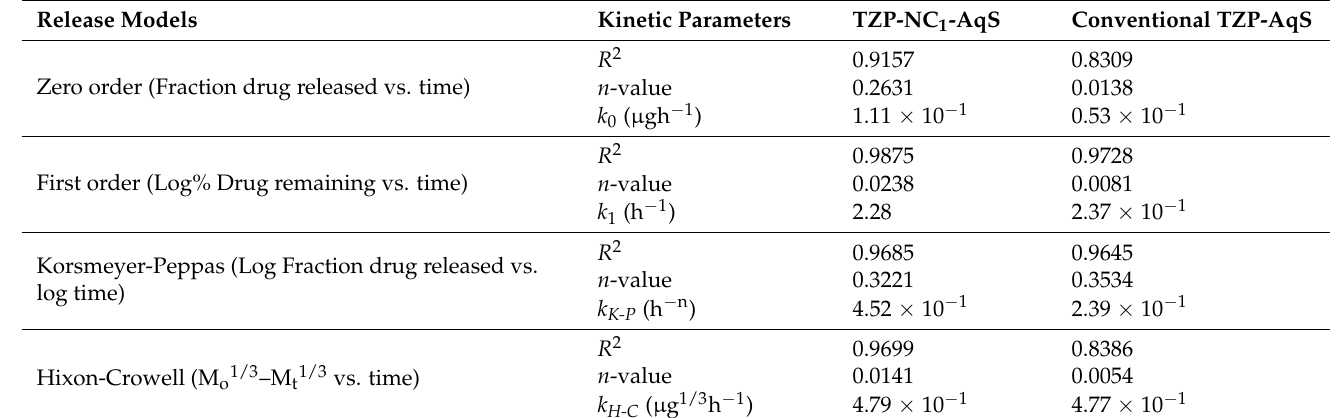
Table 5. Obtained parameters after applying the release kinetic